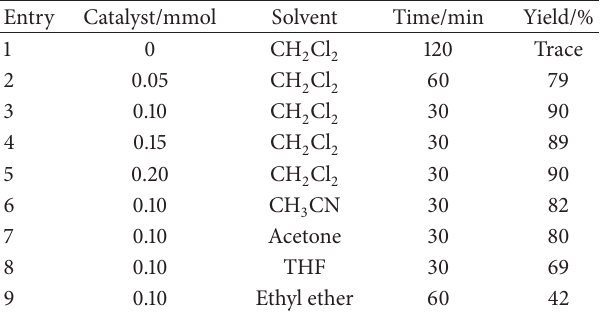
with 10 mL water and extracted with CH 2 Cl 2 (3 × 10 mL).